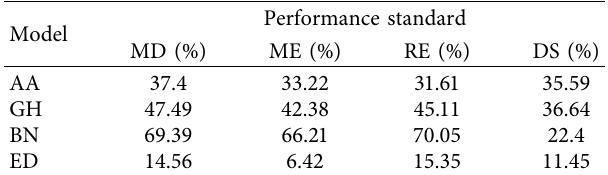
Table 3: Performance measurement results for each prediction model.